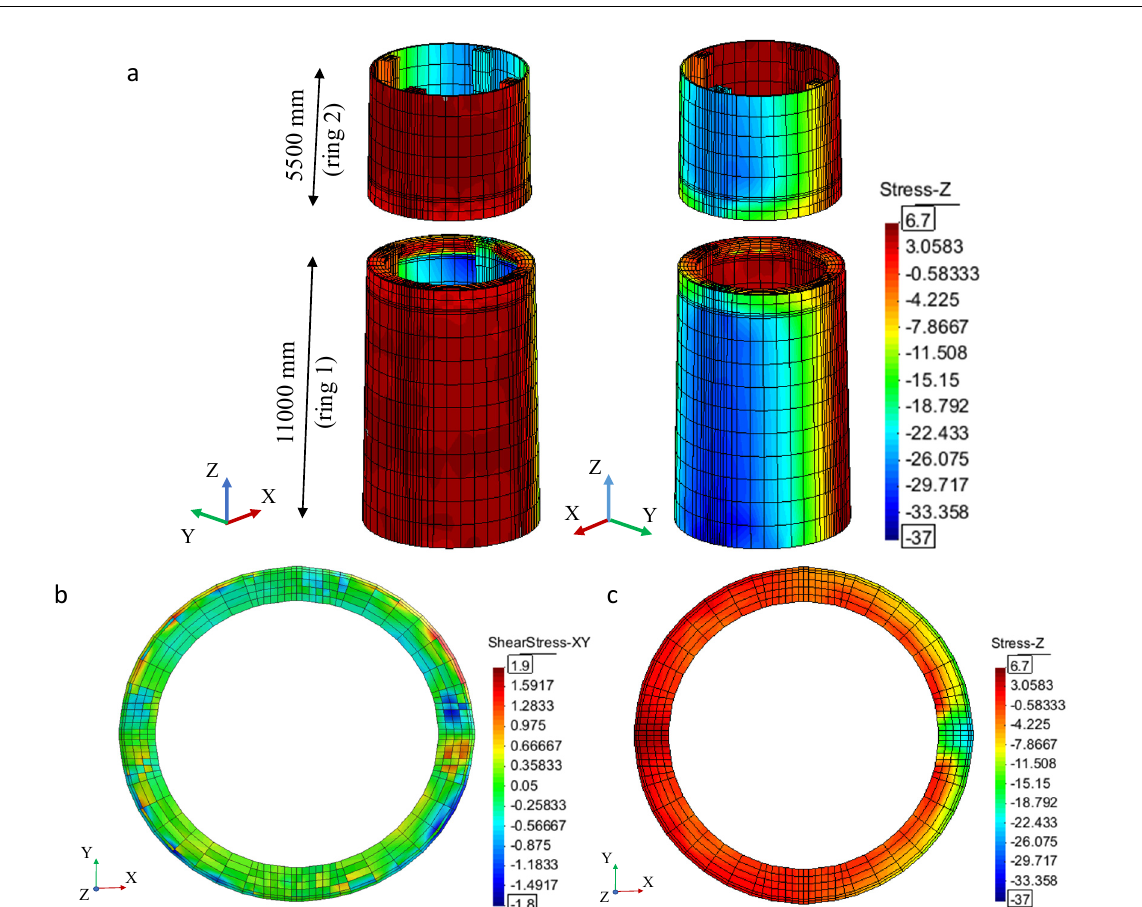
Figure 8. Model “t_s1”: (a) Z ‐ stress field; (b) shear stress field (interface layer) and (c) Orthogonal stresses interface layer) (all values are in